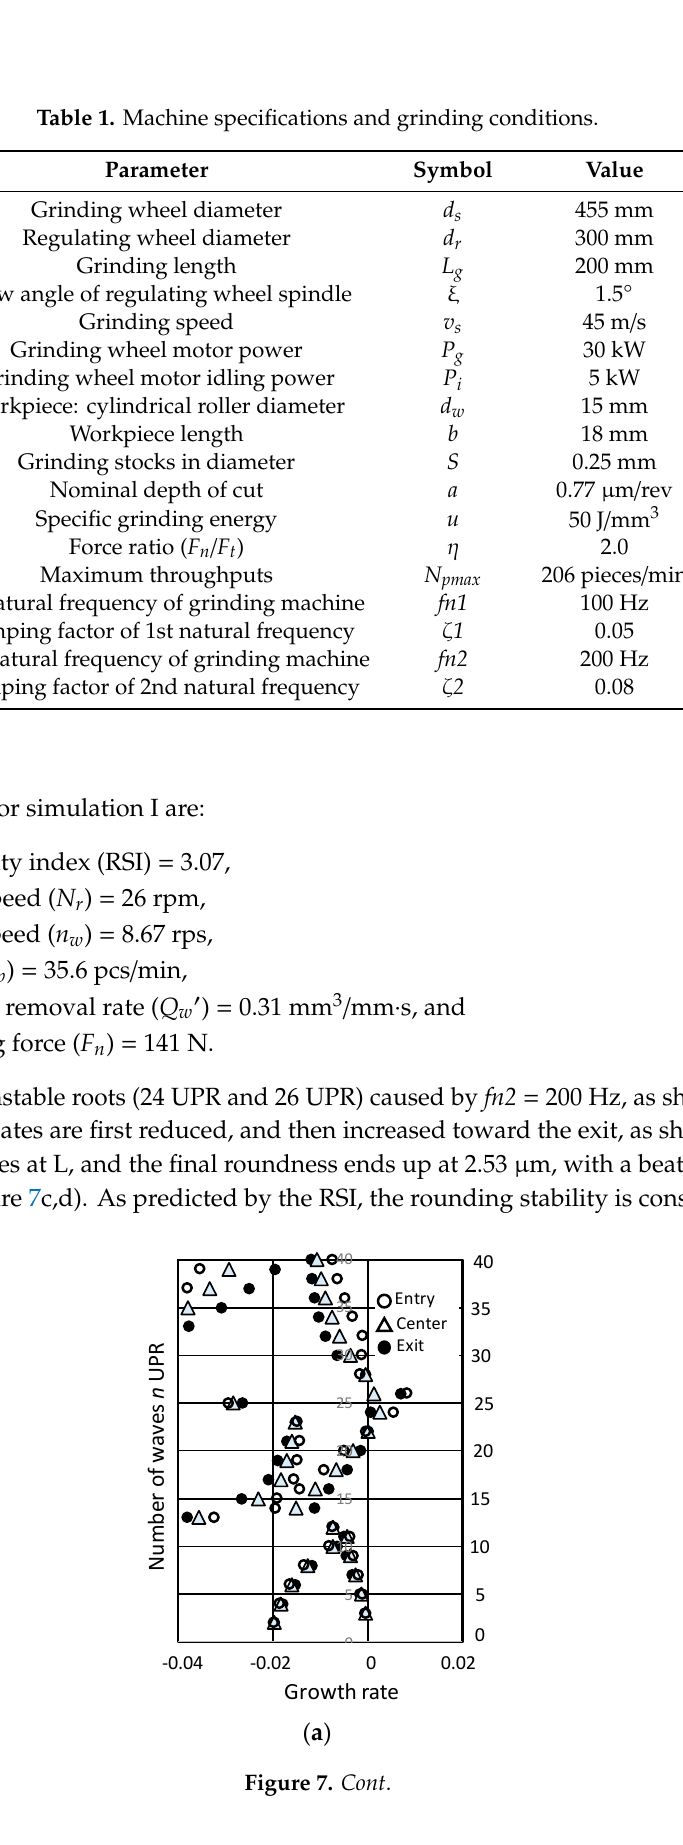
( b ) ( c ) ( d ) Figure 7. Simulation I: Unstable process RSI = 3.07. ( a ) Characteristic root distributions; ( b ) Growth rates of 24 UPR and 26 UPR; ( c ) Roundness vs. grinding positions; ( d ) Progress of roundness. 5.2. Simulation II The conditions for simulation II are: 